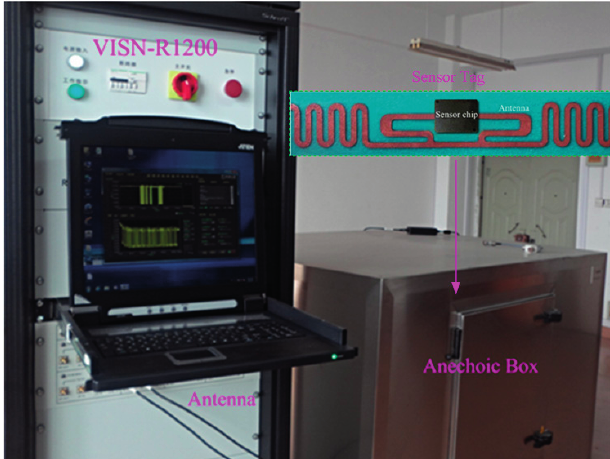
Figure 10. Photo of the wireless sensor tag.